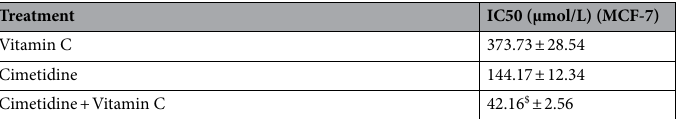
Table 2. Evaluation of the half-maximal inhibitory concentrations (IC50) of tested drugs on MCF-7 human cell line using MTT assay. Data are presented as the mean ± SD of the IC50 (μ mol/L), n = 3. $ is significantly different from cimetidine at p-value < 0.05.